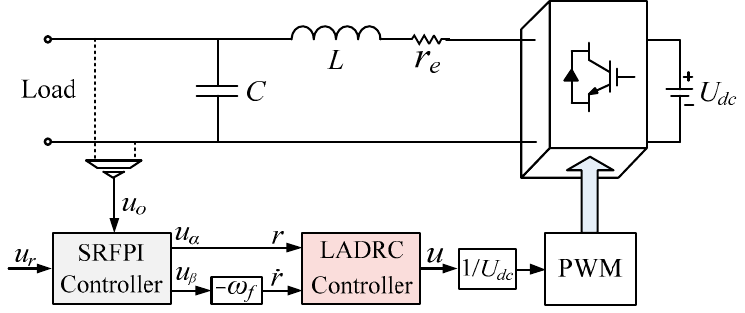
Figure 5. Control structure of SRFPI-LADRC-based voltage controller for single-phase inverter.